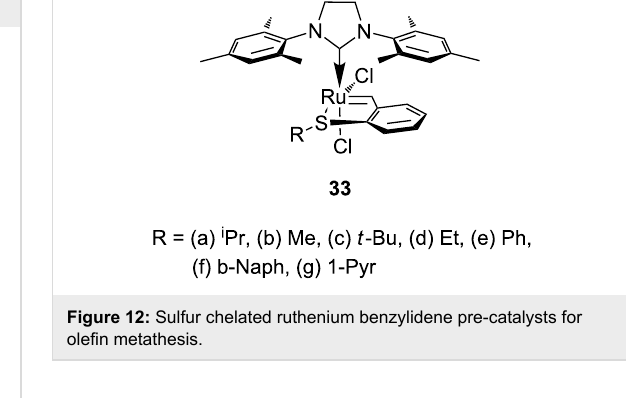
Table 5: PROMP with sulfur chelated complexes a